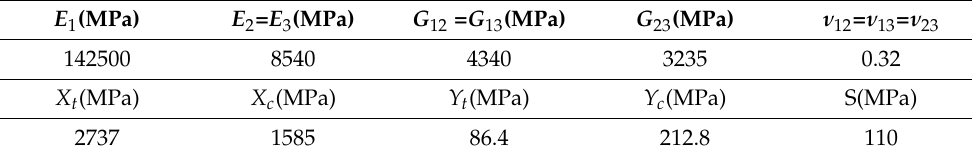
Table 2. Material properties of the T800/epoxy